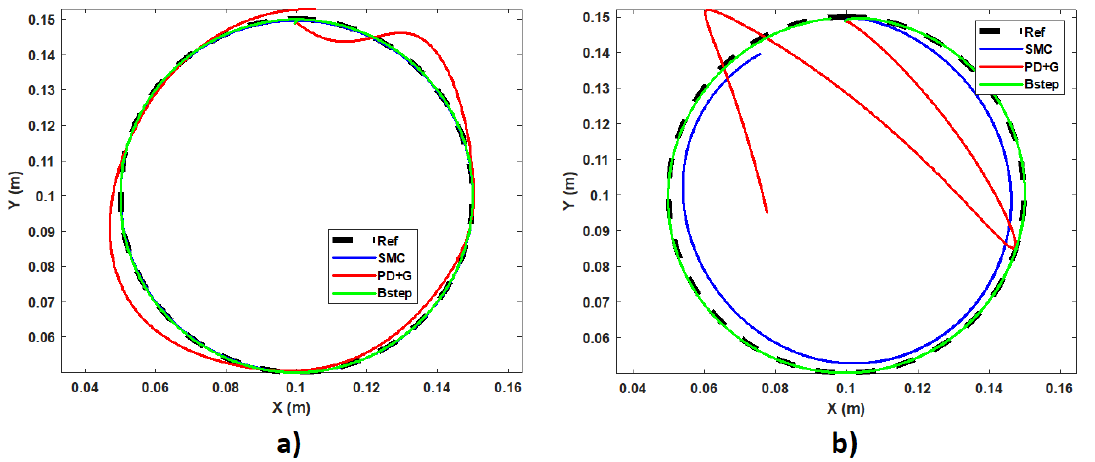
Figure 14. Cartesian motion of the end effector at different freq. ( a ) w = 0.2 rad/s, ( b ) w = 2.1 rad/s.